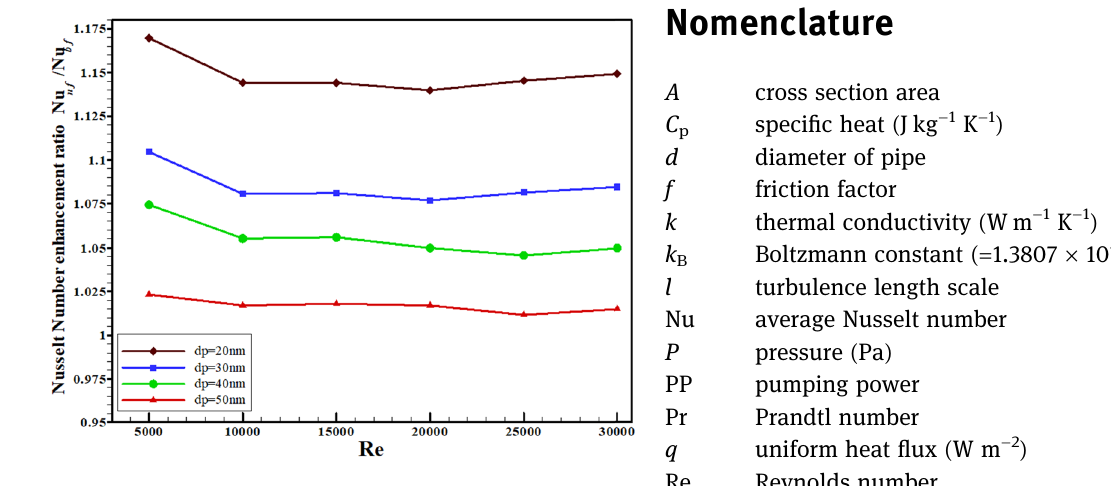
Figure 9: The enhancement ratio versus Reynolds number for var - ious metal oxide nanoparticles diameters of water/SiO 2 nano fl uid with ϕ =